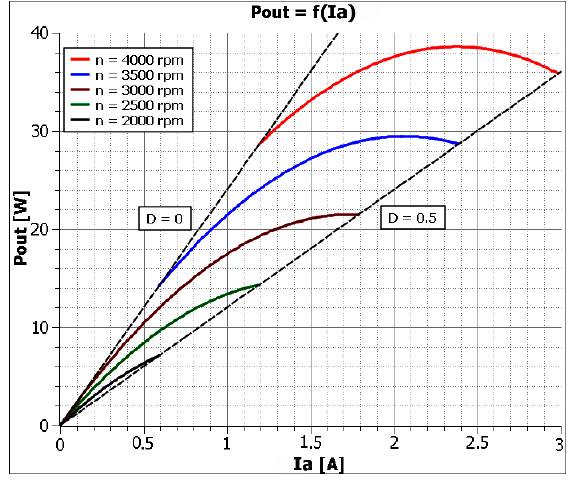
Figure 4. Output power P out as a function of the average generator current I a for different rotational speeds.